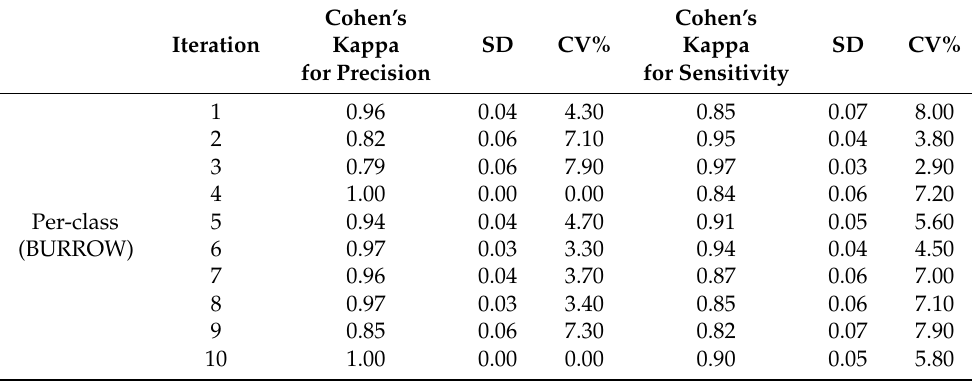
Table 3. How per-class (BURROW) Cohen’s kappa, standard deviation (SD), and coefficient of variation (CV%) for precision and sensitivity changed during the 10 iterations. For each iteration, different training (63%) and test (37%) subsets were selected randomly from the complete dataset. Cohen’s Cohen’s Iteration Kappa SD CV% Kappa SD CV% for Precision for Sensitivity 1 0.96